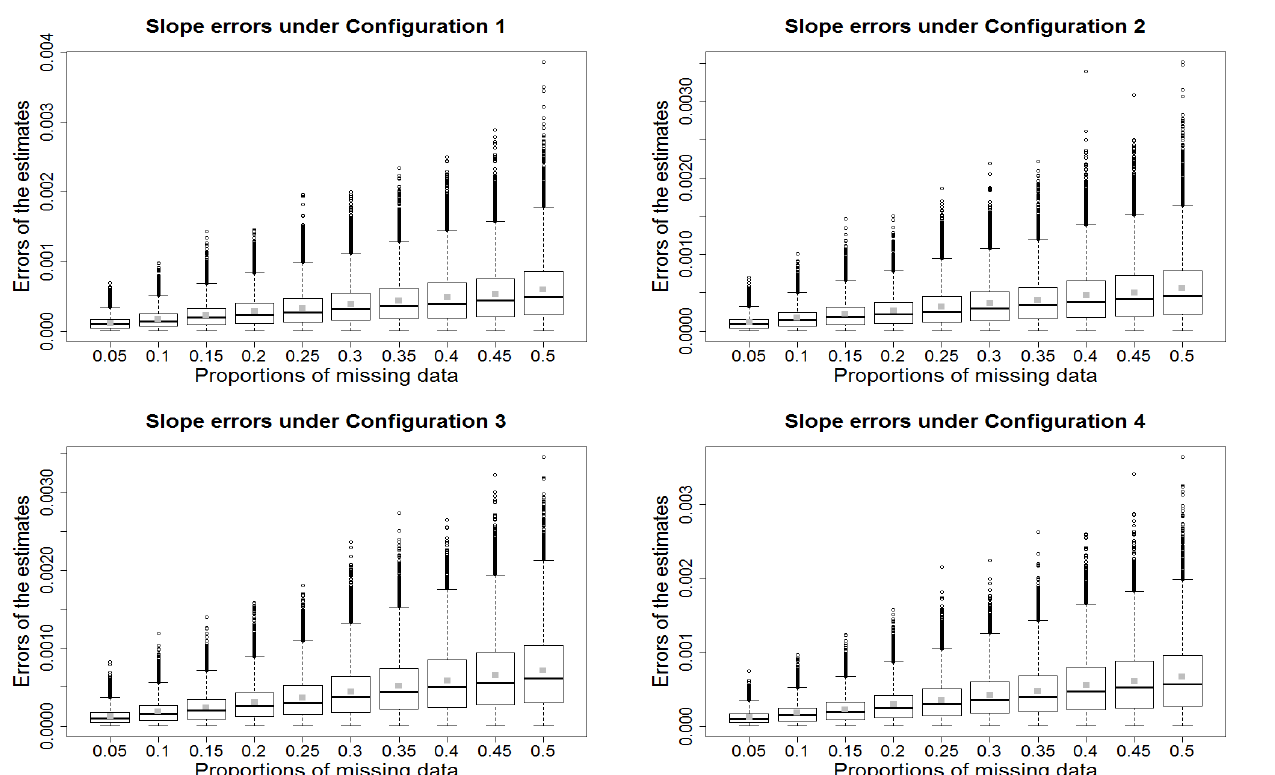
Figure 3. Boxplots of the slope errors (in degree Celsius per month change) under different